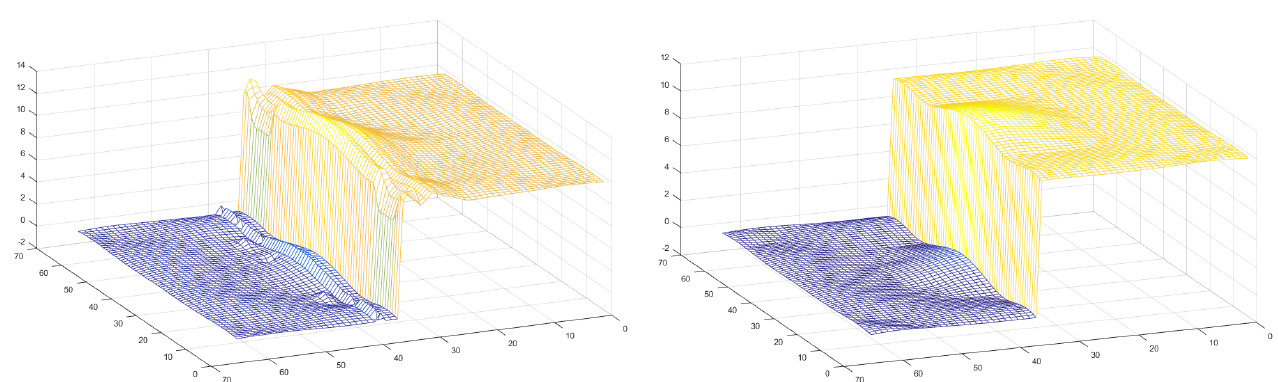
Figure 3. Obtained reconstructions after the compression (93%) and decompression process using 2 scales of different MR algorithms. Top-left: Original, Top-right: LAG, Bottom-left: ENO, Bottom-right: GM 1 .